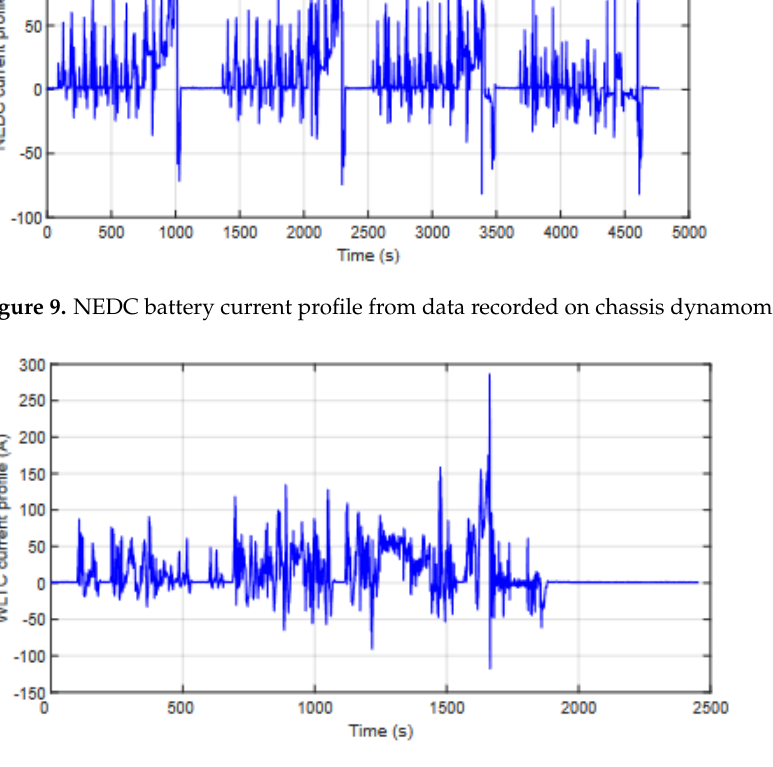
Table 4. Results of parameter